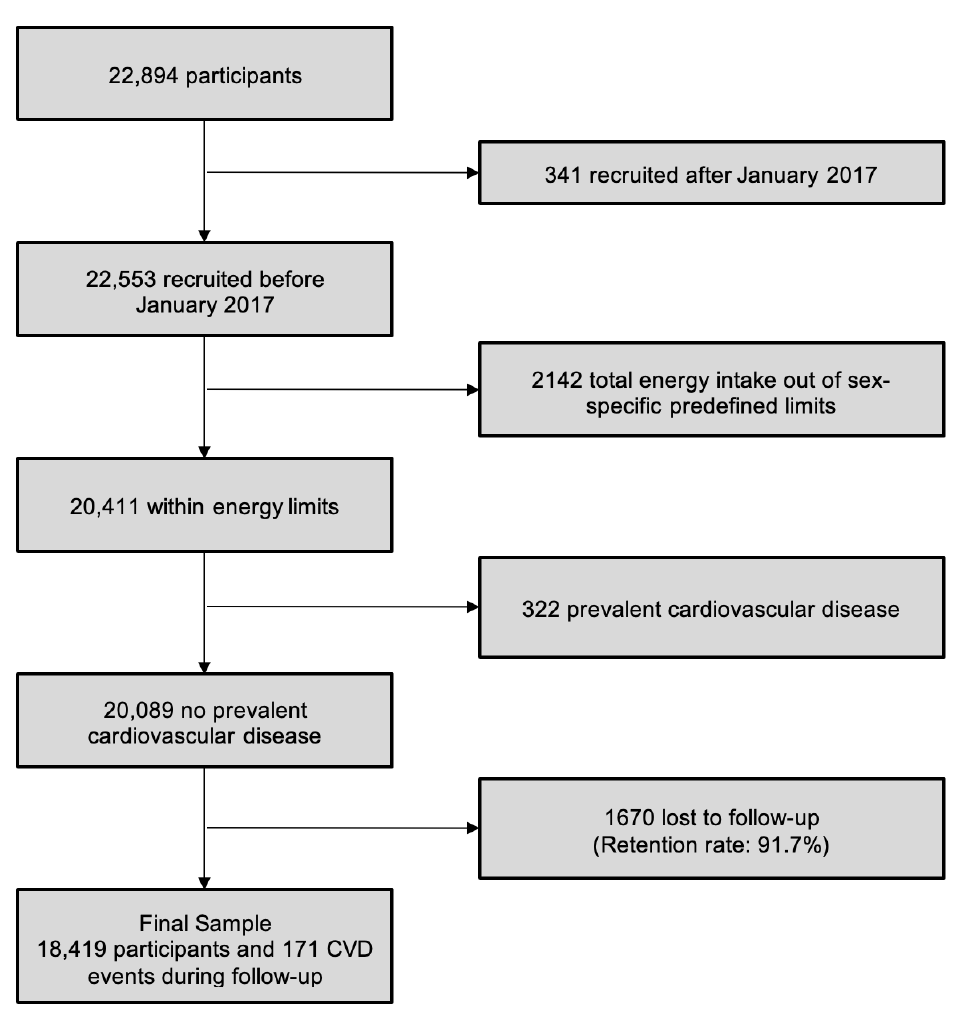
Figure 1. Flow-chart of participants in the SUN cohort in the 2019 data set.